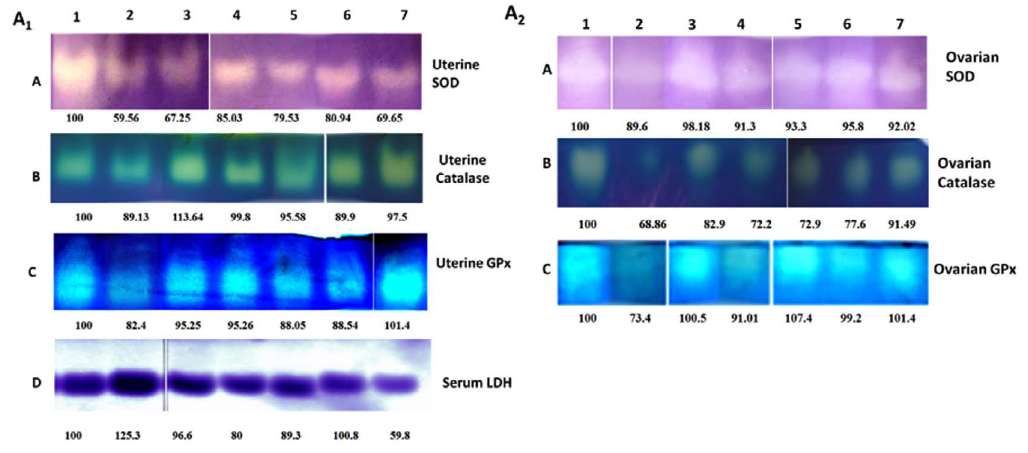
Fig. 1. Protective effect of spirulina and probiotics on uterine and ovarian tissue SOD, Catalase, GPx and serum LDH in As 3+- intoxicated rats. (A, B and C) SOD, CAT and GPx expression in uterine tissue on native gel and (D) Serum profiles of LDH activity was performed on agarose gel electrophoresis followed by substrate specific development of SOD, CAT, GPx and LDH bands. Lane distribution Lane 1: Control; Lane 2: Arsenic; Lane 3: Probiotics; Lane 4: Arsenic + Probiotics; Lane 5: Spirulina; Lane 6: Arsenic + Spirulina; Lane 7: Arsenic + Spirulina +